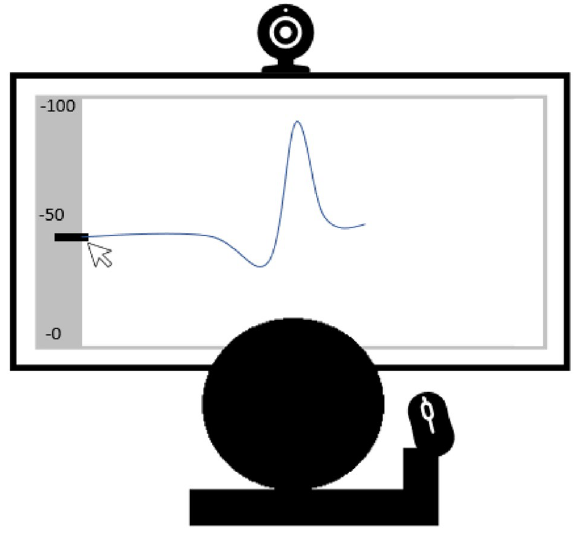
Figure 1. While performing the urge monitor task, participants were seated in front of a computer screen, using a computer mouse to continuously report their current subjective urge level on a vertical scale (0–100). Participants’ upper-body movements were video-recorded for subsequent video-based tic